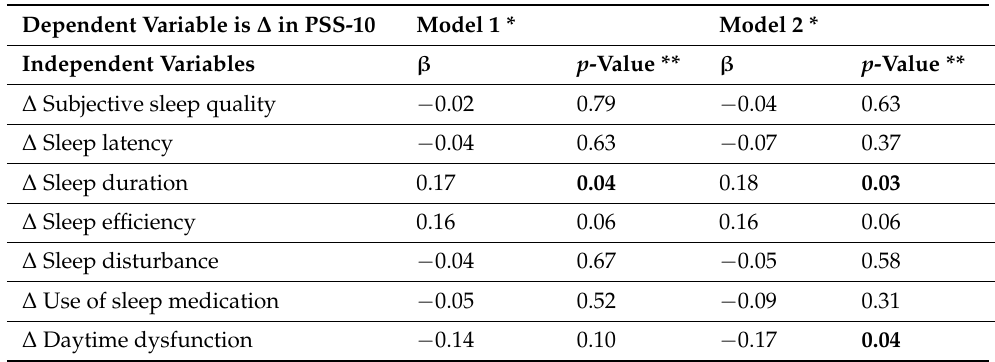
Table 5. Results of regression analysis displaying the association between changes in PSS-10 scores as dependent variable and changes in the seven PSQI components as independent variables. Dependent Variable is ∆ in PSS-10 Model 1 * Model 2